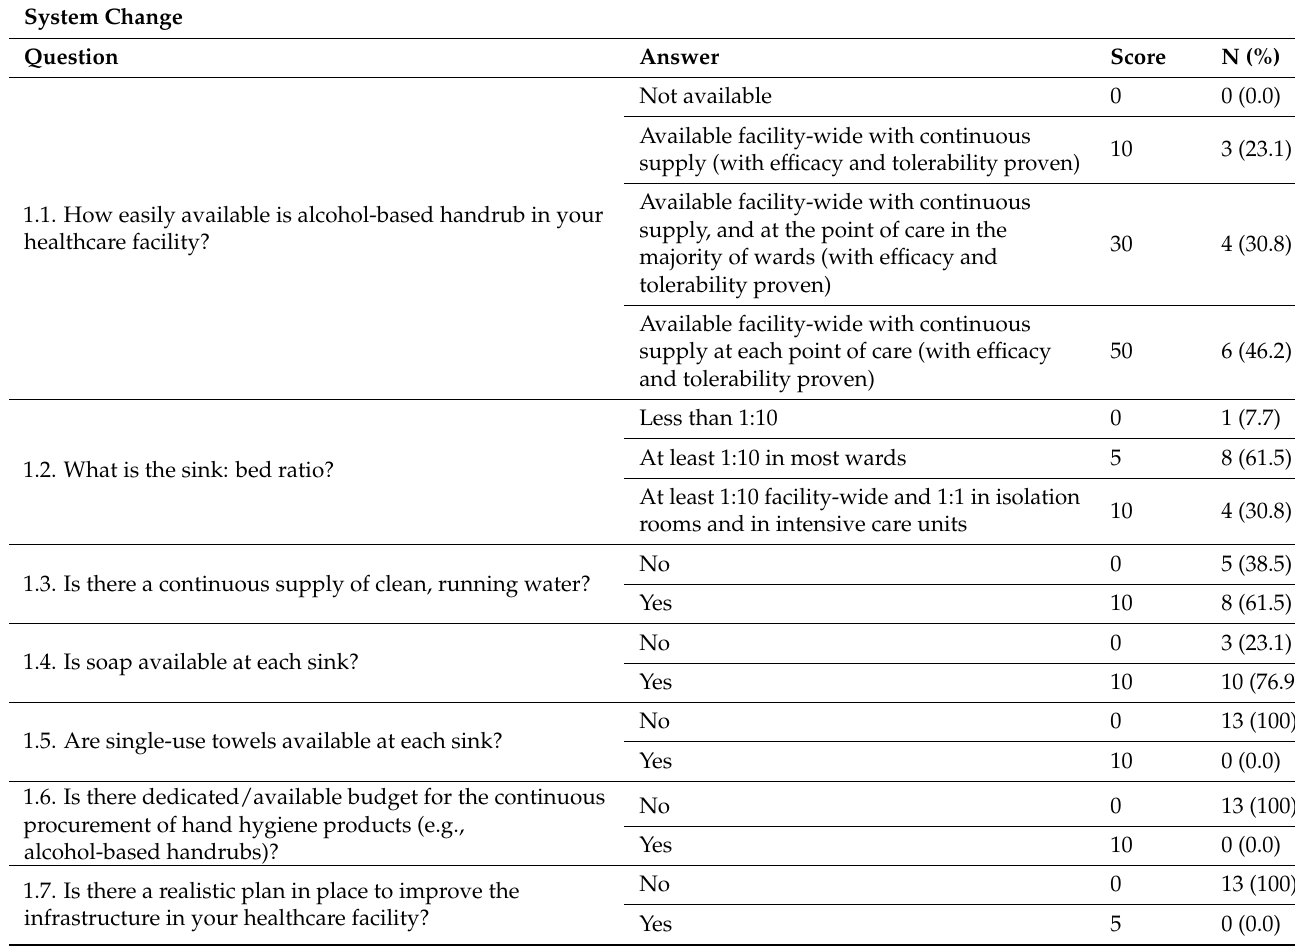
Table A1. Specific hand hygiene indicators of the 2021 HHSAF tool of 13 public